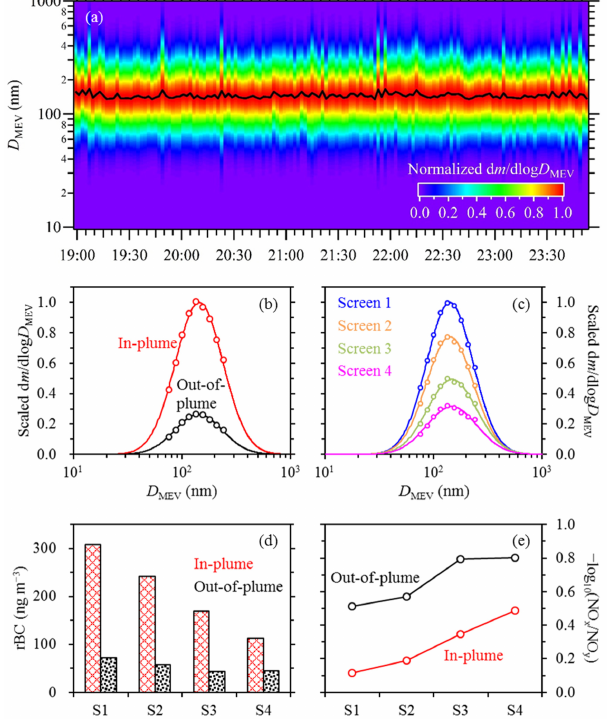
Figure 7. (a) Time-resolved rBC mass size distribution observed during the transformation flight F_9/4, (b) comparison of rBC mass size distributions between typical in- and out-of-plume conditions, (c) comparison of in-plume rBC mass size distributions among suc- cessive flight screens, and evolutions of (d) average rBC mass con- centration and (e) photochemical age from screen 1 (S1) to screen 4 (S4). Scaling of out-of-plume rBC size distribution in (b) , scal- ing of rBC size distributions for screens 2 to 4 in (c) , and reason for excluding results from screen 5 in (c) to (e) are explained in the text.